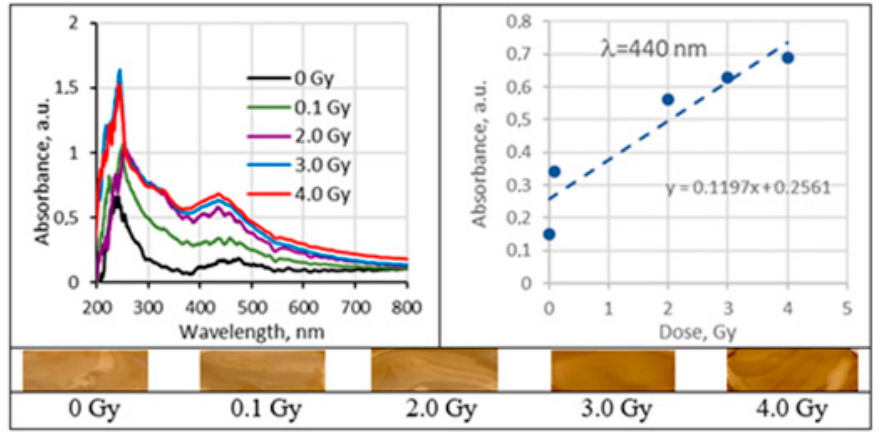
Figure 12. Absorbance and sensitivity of 6 MeV irradiated 1AgEthaPVA films.